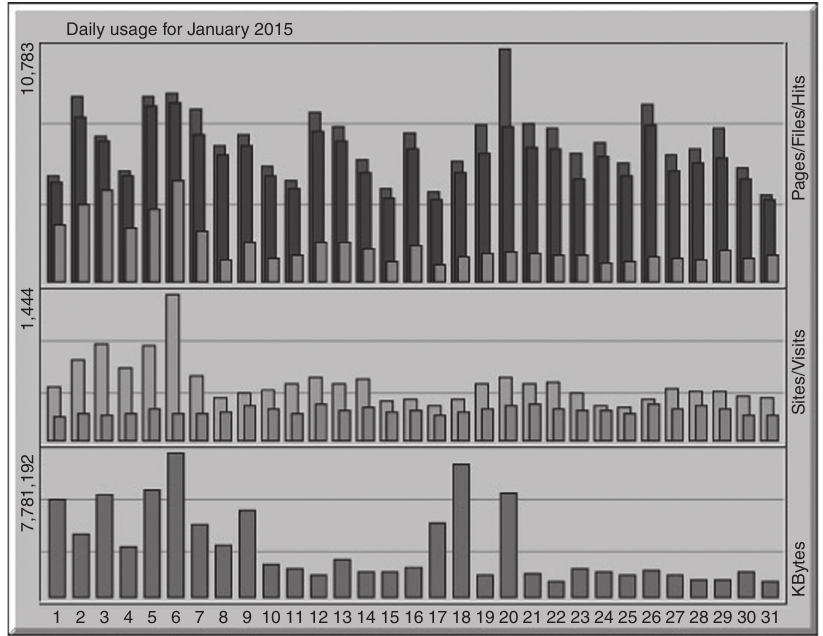
Figure 4. Daily usage for